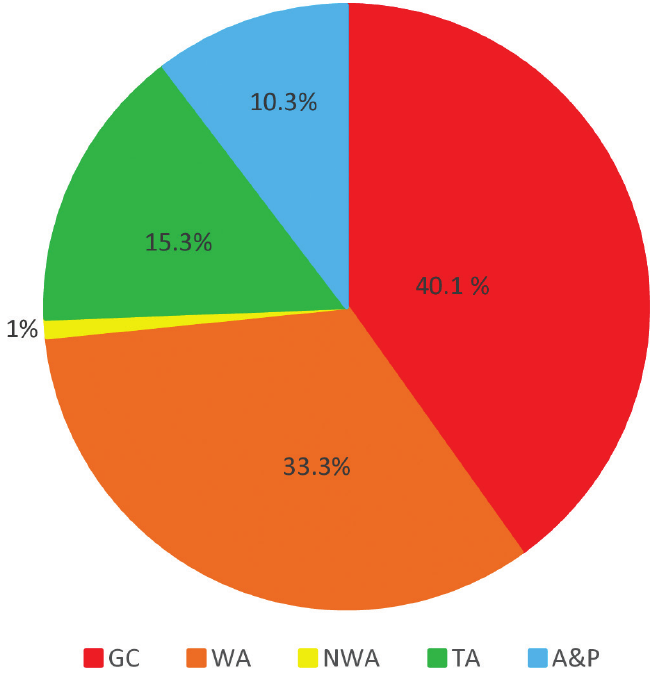
Figure 3. Percentages of the Sint Eustatius marine fish fauna represented by groups of species with dif- ferent global geographical ranges. GC = Greater Caribbean endemics; NWA = GC plus temperate eastern USA; WA = GC plus Brazil; TA = WA plus central or East Atlantic; and A&P = species found in both the Atlantic and various parts of the